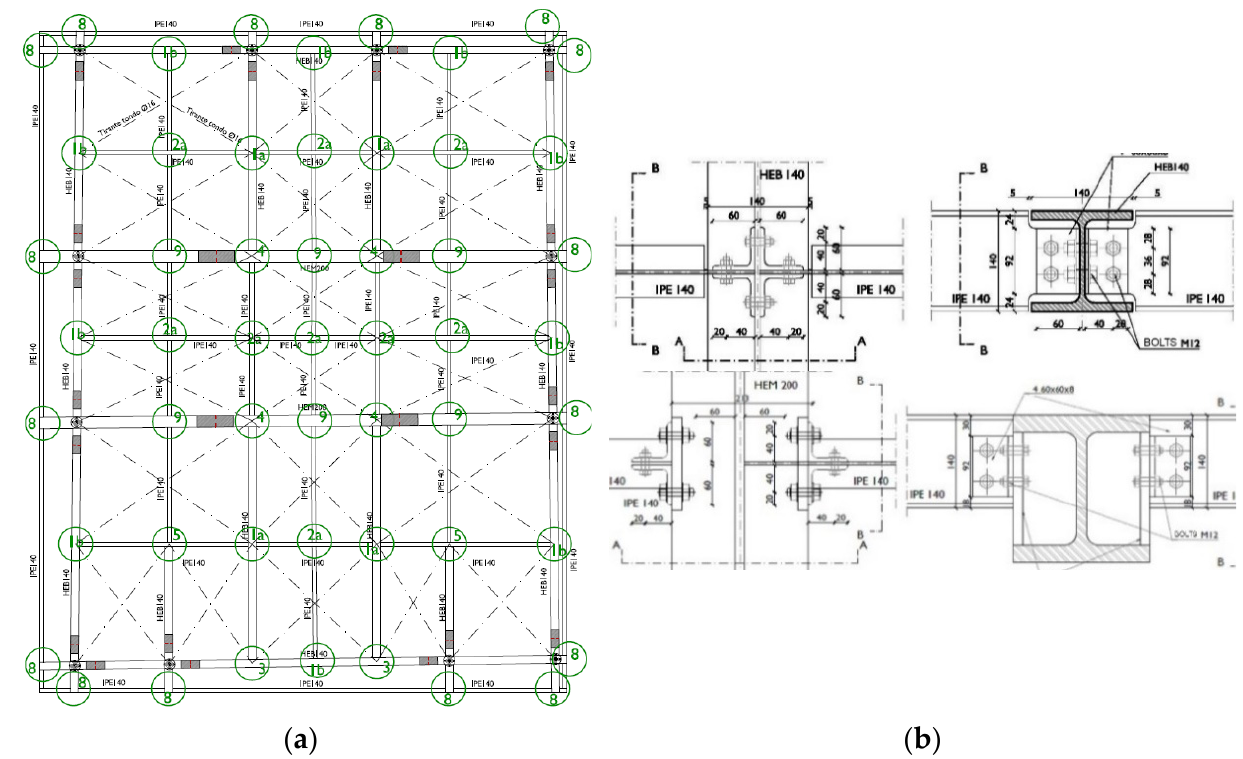
Figure 13. Structural design. ( a ) Detail of the roofs in plane.( b ) Joint detail.